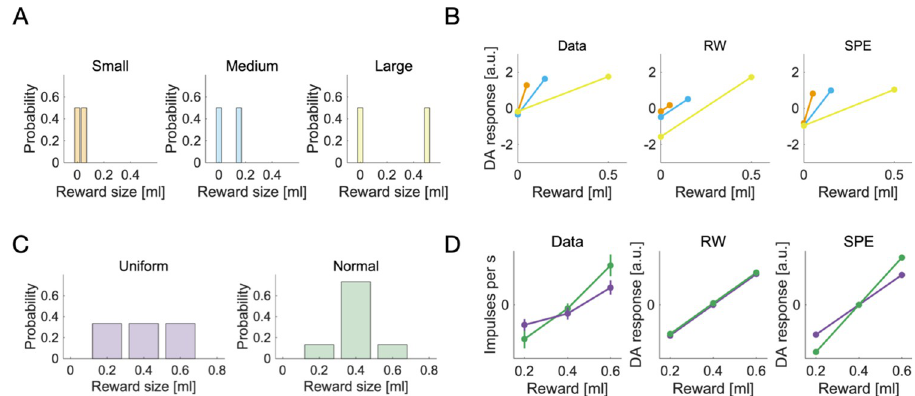
Fig 3. Dopamine responses to unpredictable rewards—experimental data and simulations. A The reward distributions used by Tobler, Fiorillo [10]. Each distribution corresponds to an experimental condition. B Dopamine responses to rewards sampled from the distributions in A are shown as a function of reward magnitude, for the three different conditions. The representation of data is similar to that in figure 4C of Tobler, Fiorillo [10]. We show experimental data, extracted from figure 4C (animal A) of Tobler, Fiorillo [10] and simulated data, using a standard RW model and the SPE model. The colors relate the dopamine responses in B to the reward distributions in A. C The reward distributions used by Rothenhoefer, Hong [21]. The panel shows the probabilities plotted by Rothenhoefer, Hong [21] in figure 1A. D Dopamine responses to rewards sampled from the distributions in C. We show the empirical values plotted by Rothenhoefer, Hong [21] in figure 2E, and the responses according to the RW model computed analytically as δ = r −μ , and the SPE model computed as d ¼ r (cid:0) m , where μ and σ are the mean and standard s deviation of corresponding reward distributions in C. Purple lines correspond to the uniform reward distribution, green lines correspond to the normal reward distribution.